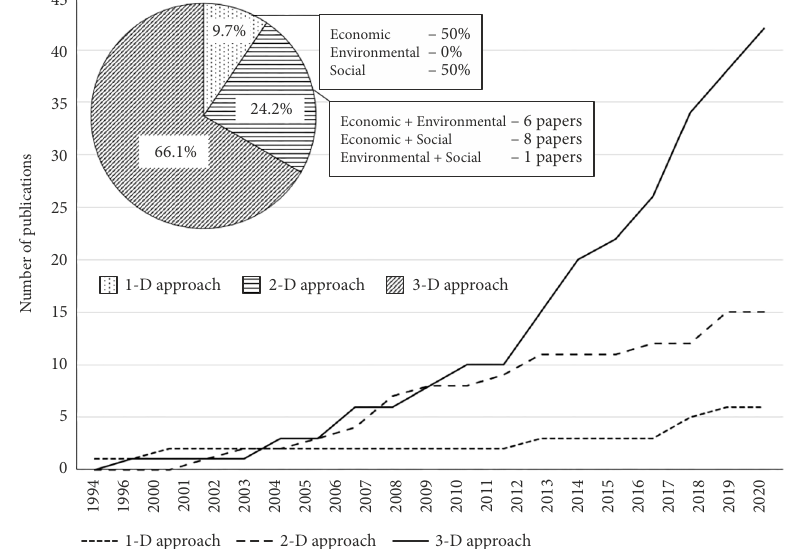
Figure 4. Dimensional approach for the sustainable assessment of bridge designs